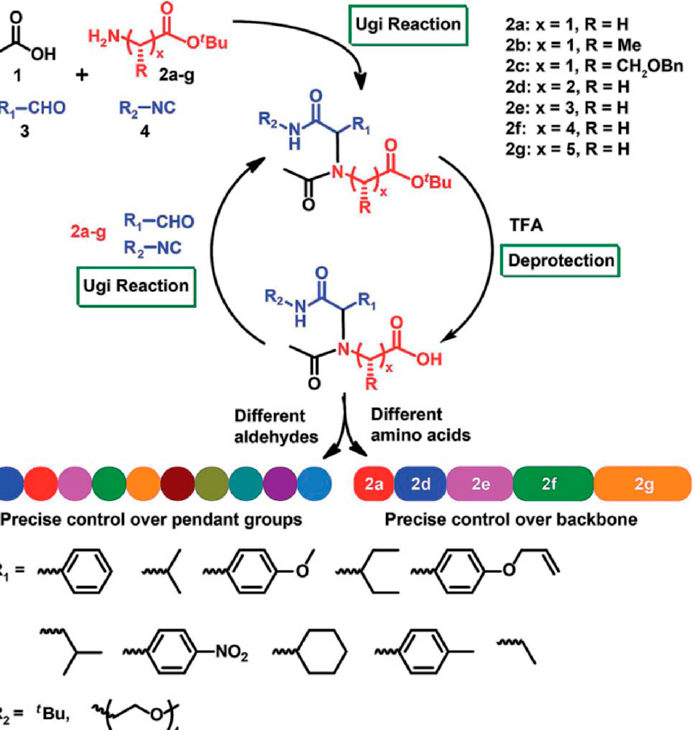
Figure 19. Synthesis strategy towards sequence-defined poly(amino acid)s via amino acid building blocks and iterative Ugi reactions. Reproduced with permission [40]. Copyright 2019, Royal Society of Chemistry.